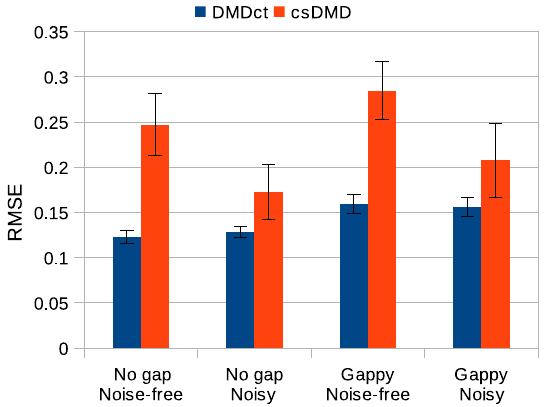
Figure 6. The mean RMSE values of the two methods for the four test cases of the Duffing dataset. Each test case consisted of twenty different random sampling masks. The error bars show the